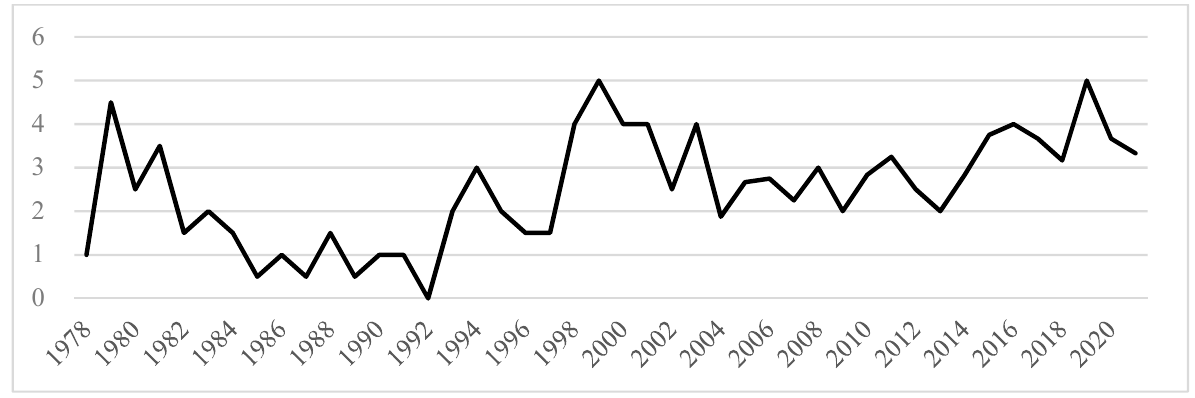
Figure 3. Line graph of the changes in the number of test items with mathematical culture. Combined with a line graph of the changes in the number of test items with mathe- matical culture in different categories (Figure 4), it can be inferred from the vertical axis that the changes in the number of test items in the categories of Social Roles , Interdisciplinary Connections , Aesthetics & Recreation , and Historical Topics showed fluctuation, although the test items of each category had their own characteristics in history. It can also be inferred from the horizontal axis that the content distribution of mathematical culture in test items of different years was also similar to the overall content distribution of mathe- matical culture in test items. In almost all years, the number of items in the category of Social Roles was the highest, followed by the categories of Interdisciplinary Connections and Aesthetics & Recreation